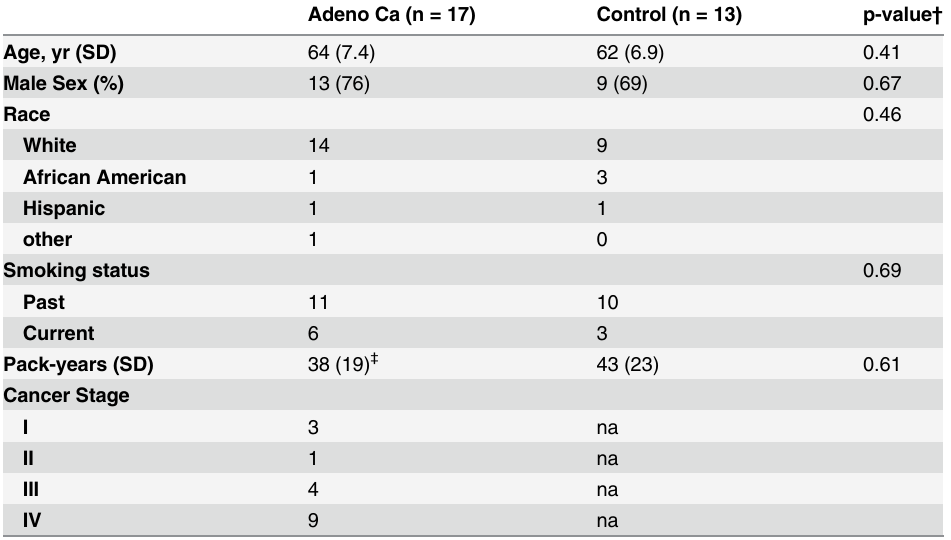
Table 1. Demographic & clinical